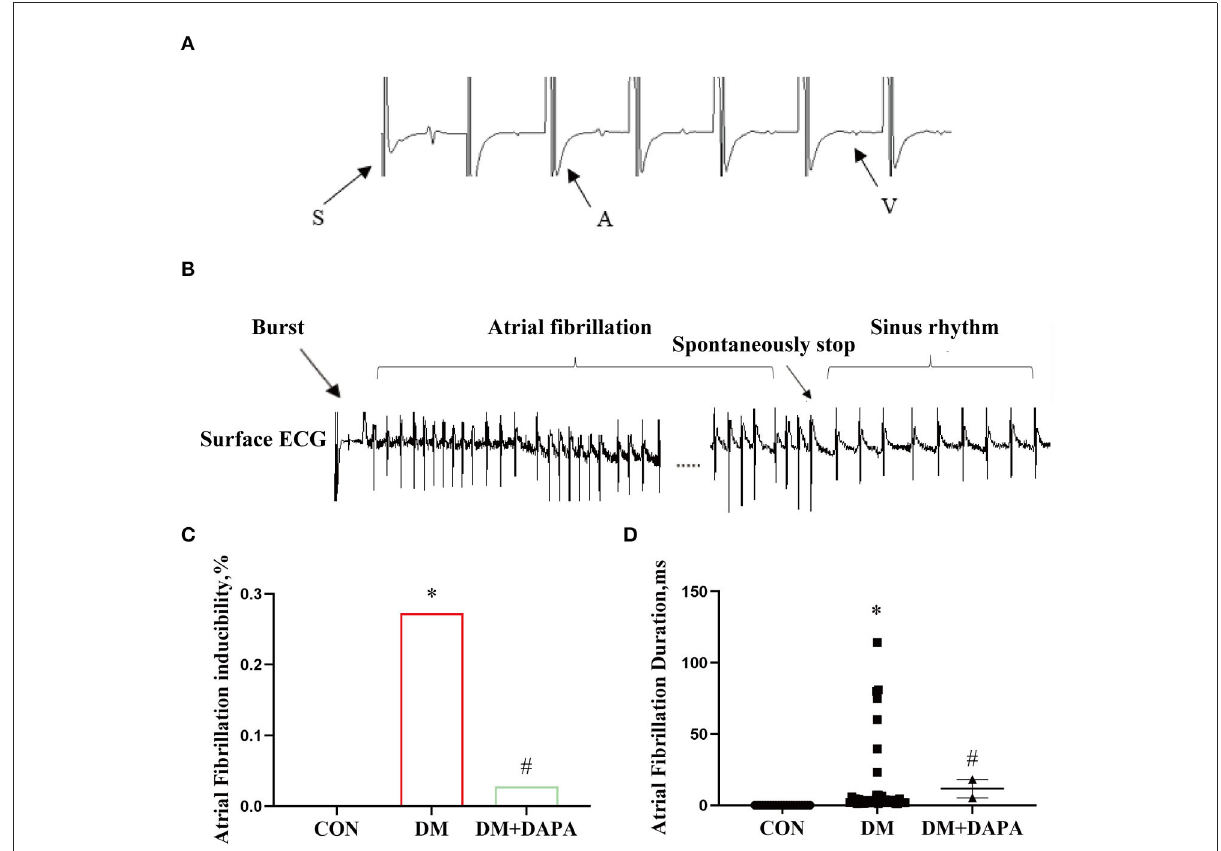
FIGURE4 DAPA could inhibit atrial electrical remodeling and the occurrence of atrial fibrillation in diabetic rats. (A) Large stimulation artifacts are recorded on the surface ECG, following atrial wave and ventricular; (B) atrial fibrillation spontaneously stops after a series of burst; (C) atrial fibrillation inducibility; (D) statistical analysis of atrial fibrillation duration. CON, control group; DM, diabetes group; DM + DAPA, diabetes + dapagliflozin group. Data are expressed as the mean ± SEM. * P < 0.05 vs. CON group. # P < 0.05 vs. DM group. The arrow represents the direction of the